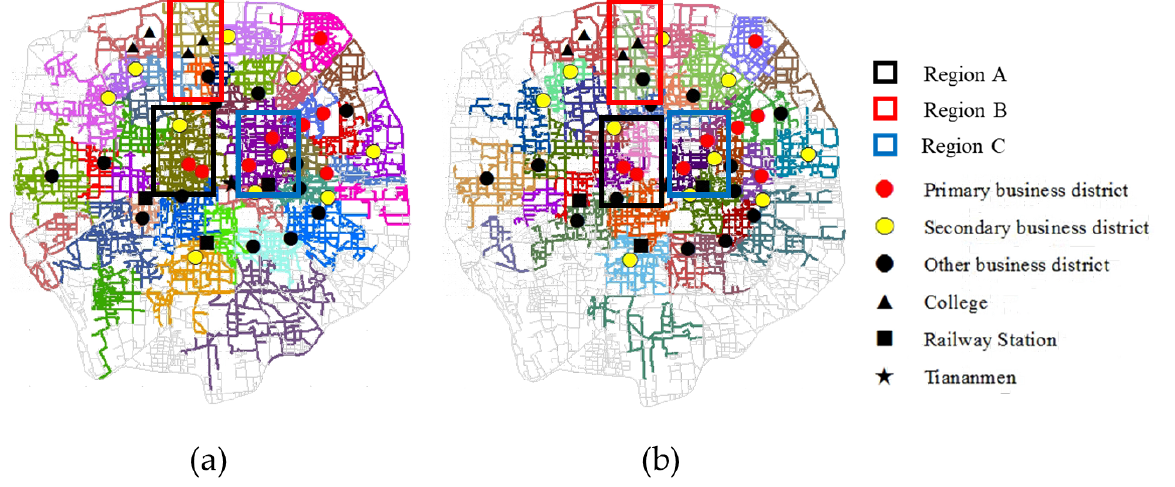
Figure 13. Overlapping results of spatial community during the morning rush hours and highlighted places: ( a ) spatial communities discovered on Monday; ( b ) spatial communities discovered on Sunday.